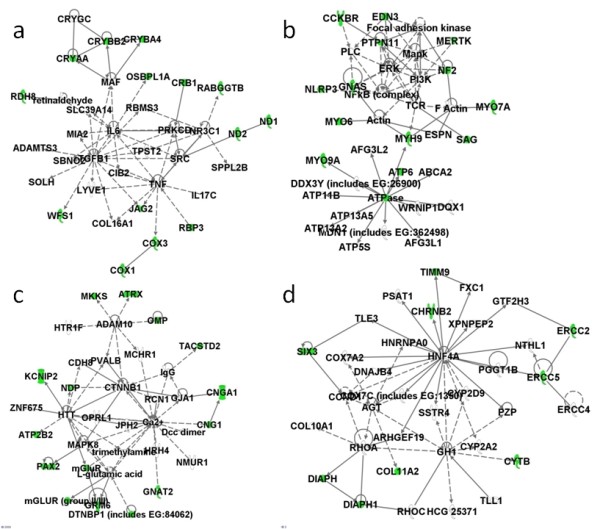
Network pathway analysis of downregulated genes in the gene category sensory perception. (a) Network 1, (b) Network 2, (c) Network 3, and (d) Network 4 constructed by 56 downregulated genes.